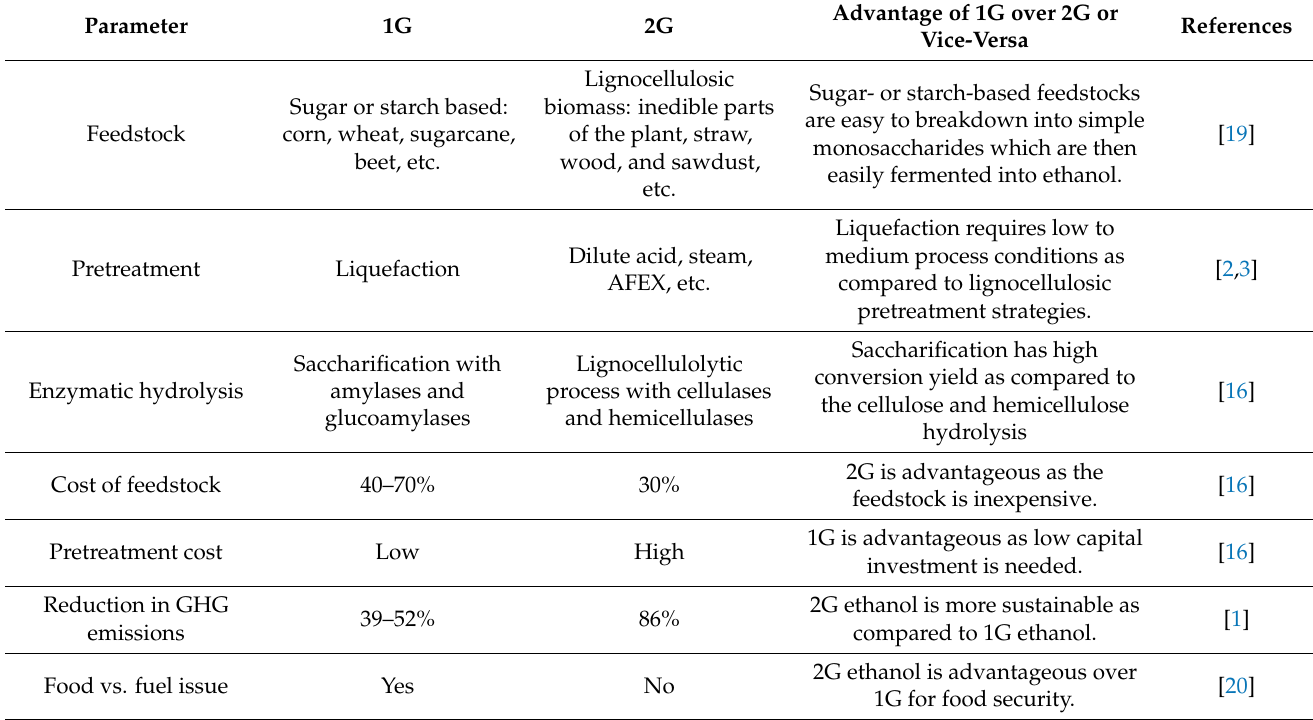
Table 1. Main differences between 1G and 2G bioethanol